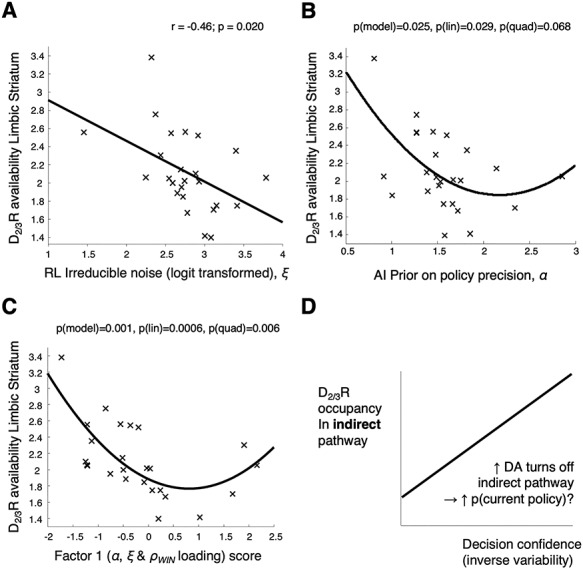
Relationships between D2/3R availability and RL and AI parameters governing response stochasticity in participants who completed PET (n = 25). (A) There is a linear relationship between irreducible decision noise \documentclass[12pt]{minimal}
\usepackage{amsmath}
\usepackage{wasysym} 
\usepackage{amsfonts} 
\usepackage{amssymb} 
\usepackage{amsbsy}
\usepackage{upgreek}
\usepackage{mathrsfs}
\setlength{\oddsidemargin}{-69pt}
\begin{document}
}{}$\xi$\end{document} and limbic striatal D2/3R availability (measured as [11C]-(+)-PHNO BPND) in the participants who completed a PET scan (r = –0.46, 95% CI [–0.72 –0.08], P = 0.020). Here, \documentclass[12pt]{minimal}
\usepackage{amsmath}
\usepackage{wasysym} 
\usepackage{amsfonts} 
\usepackage{amssymb} 
\usepackage{amsbsy}
\usepackage{upgreek}
\usepackage{mathrsfs}
\setlength{\oddsidemargin}{-69pt}
\begin{document}
}{}$\xi$\end{document} was logit transformed as it was not normally distributed: \documentclass[12pt]{minimal}
\usepackage{amsmath}
\usepackage{wasysym} 
\usepackage{amsfonts} 
\usepackage{amssymb} 
\usepackage{amsbsy}
\usepackage{upgreek}
\usepackage{mathrsfs}
\setlength{\oddsidemargin}{-69pt}
\begin{document}
}{}$\mathrm{logit}\left(\xi \right)=\ln \left(\xi /\left[1-\xi \right]\right)$\end{document}. Without the transform, the correlation remained significant (r = –0.45, 95% CI [–0.72 –0.07], P = 0.023). (B) There is a significant linear relationship between the prior on policy precision \documentclass[12pt]{minimal}
\usepackage{amsmath}
\usepackage{wasysym} 
\usepackage{amsfonts} 
\usepackage{amssymb} 
\usepackage{amsbsy}
\usepackage{upgreek}
\usepackage{mathrsfs}
\setlength{\oddsidemargin}{-69pt}
\begin{document}
}{}$\alpha$\end{document} and D2/3R availability, βlinear = –2.1, SE = 0.91, t22 = –2.33, P =0.029; there is also evidence of a quadratic relationship but it is not significant, βquad = 0.49, SE = 0.26, t22 = 1.92, P = 0.068. (C) This plot shows the relationships between D2/3R availability and the first factor in the factor analysis of the AI and RL parameters (detailed in Fig. S9). Three parameters governing response stochasticity loaded on this factor (loadings in brackets) – \documentclass[12pt]{minimal}
\usepackage{amsmath}
\usepackage{wasysym} 
\usepackage{amsfonts} 
\usepackage{amssymb} 
\usepackage{amsbsy}
\usepackage{upgreek}
\usepackage{mathrsfs}
\setlength{\oddsidemargin}{-69pt}
\begin{document}
}{}$\alpha$\end{document} (0.69), \documentclass[12pt]{minimal}
\usepackage{amsmath}
\usepackage{wasysym} 
\usepackage{amsfonts} 
\usepackage{amssymb} 
\usepackage{amsbsy}
\usepackage{upgreek}
\usepackage{mathrsfs}
\setlength{\oddsidemargin}{-69pt}
\begin{document}
}{}${\rho}$\end{document}win (0.88), and \documentclass[12pt]{minimal}
\usepackage{amsmath}
\usepackage{wasysym} 
\usepackage{amsfonts} 
\usepackage{amssymb} 
\usepackage{amsbsy}
\usepackage{upgreek}
\usepackage{mathrsfs}
\setlength{\oddsidemargin}{-69pt}
\begin{document}
}{}$\xi$\end{document} (0.30)—and this factor has robust linear (βlinear = –0.29, SE = 0.07, t22 = –3.97, P = 0.0006) and quadratic (βquad = 1.8, SE = 0.06, t22 = 3.06, P =0.006) relationships with D2/3R availability. (D) We interpret the linear relationships in plots A–C as being due to greater tonic D2R occupancy suppressing the indirect pathway more, hence making participants’ choices more deterministic.